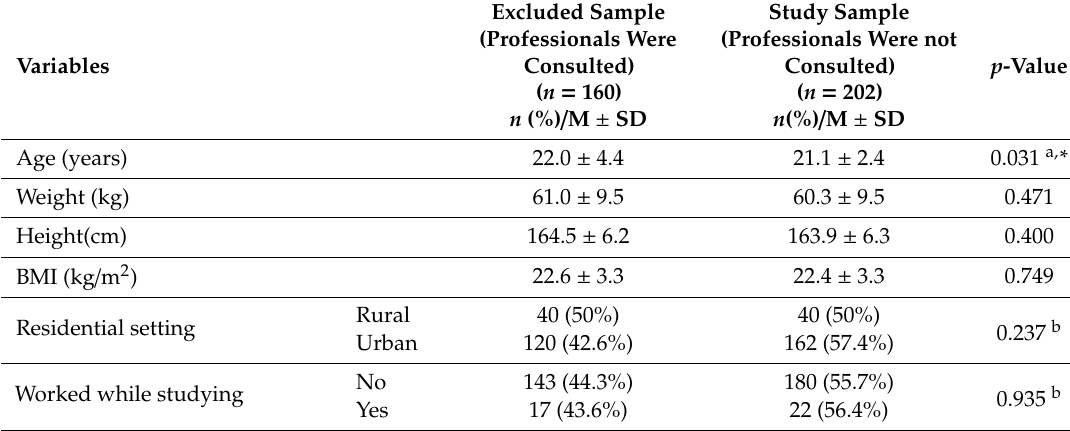
Table 1. Comparison of the characteristics of the women who consult health professionals and those who chose not to do